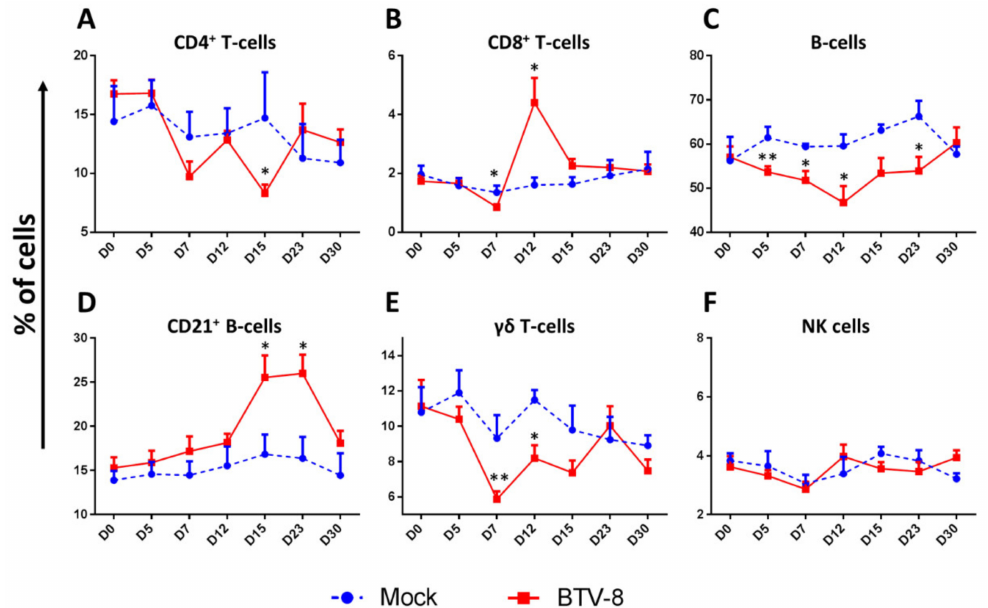
Figure 4. Flow cytometry analysis of lymphoid cell population in PBMC following BTV-8 infection. PBMC were obtained prior to infection (day 0), and at day 5, 7, 12, 15, 23, and 30 post-infection from BTV-8 or mock-infected sheep. (A–F) Flow cytometry analysis was performed to assess the percentage of CD4 + T-cells, CD8 + T-cells, B-cells, CD21 + B-cells, γδ T-cells, and NK cells in isolated PBMC. ( A ) CD4 + T-cell percentage decreased at day 7 post-BTV infection and was significantly lower at day 12 post-BTV infection when compared to mock-infected sheep. ( B ) CD8 + T-cell percentage decreased at day 7 post-infection and peaked at day 12 post-infection in BTV-infected sheep. ( C ) B-cell percentage decreased from day 5 up to day 23 post-infection in BTV infected sheep and only recovered to similar levels to mock-infected sheep by day 30. ( D ) Mature B-cells (CD21 + B-cells) percentage peaked in BTV-infected sheep at day 15 to day 23 post-infection when compared to mock-infected counterparts. ( E ) γδ T-cell percentage decreased by day 7 post-BTV infection and only recovered to levels similar to mock-infected animals by day 23 post-infection. ( F ) NK cell percentage did not appear to significantly change in BTV-infected sheep when compared to mock-infected